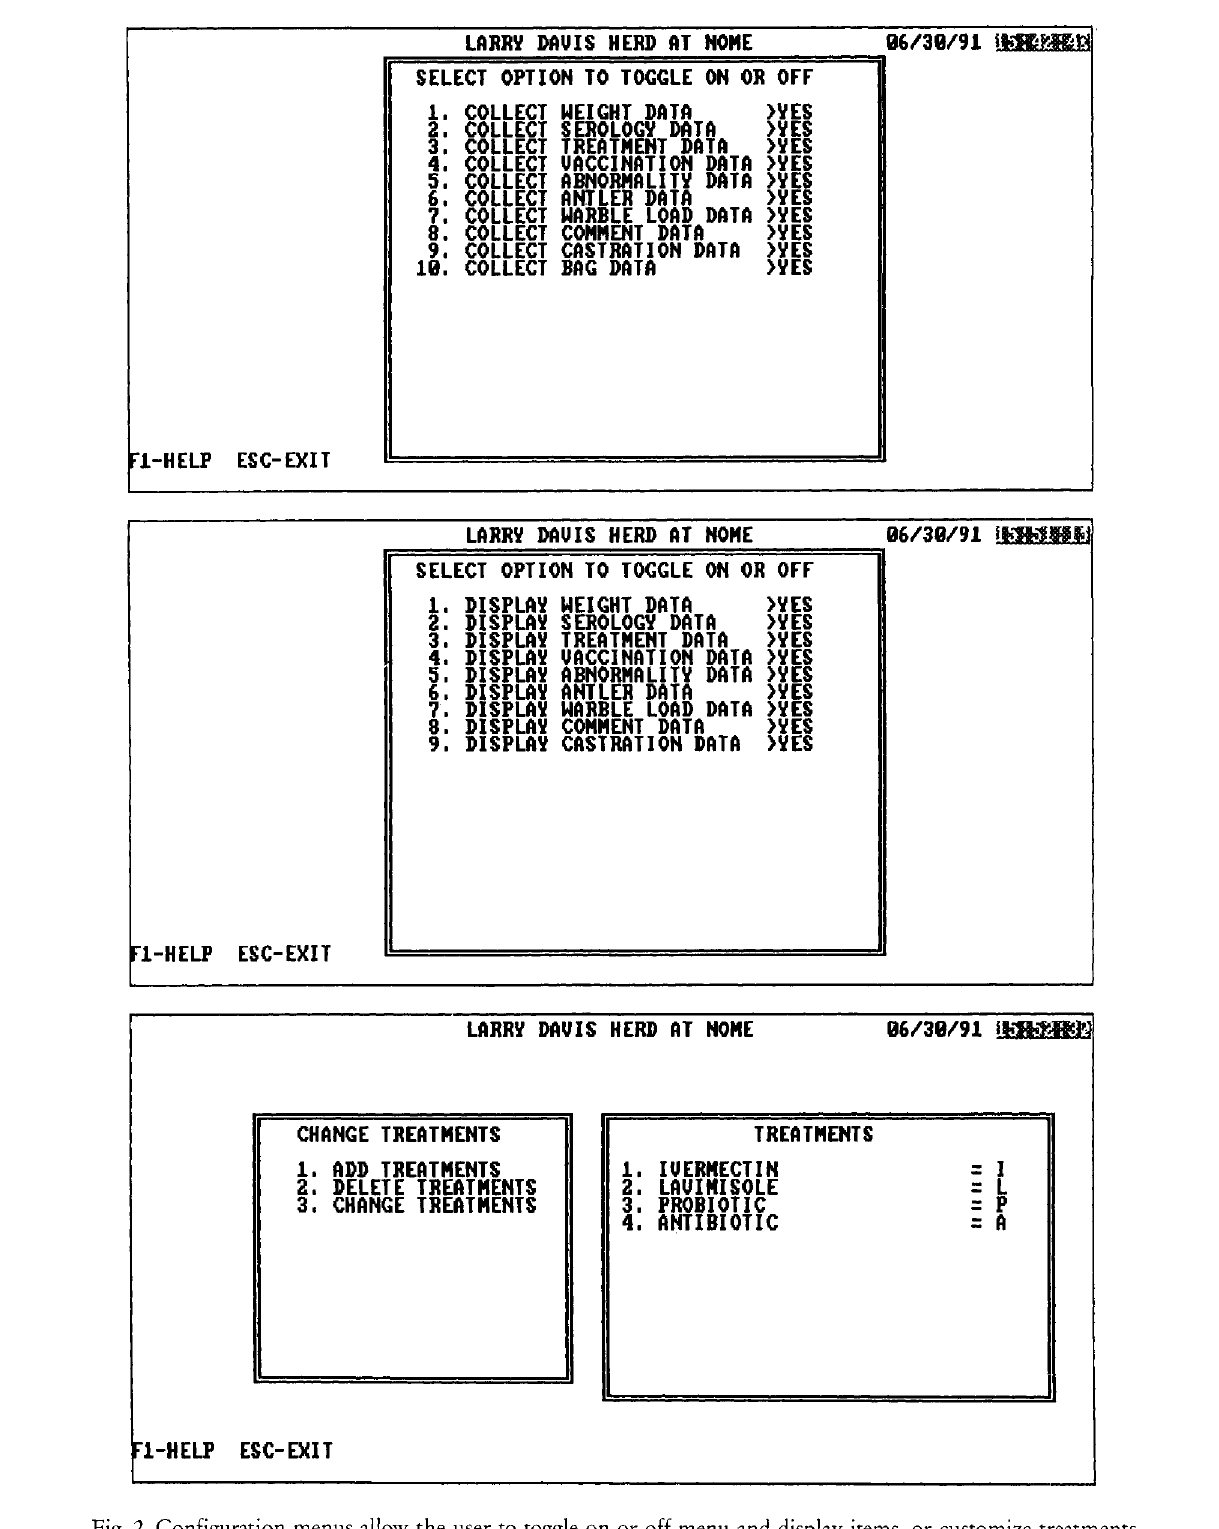
Fig. 2. Configuration menus allow the user to toggle on or off menu and display items, or customize treatments, vaccinations, tests, and abnormalities specific to each herd or